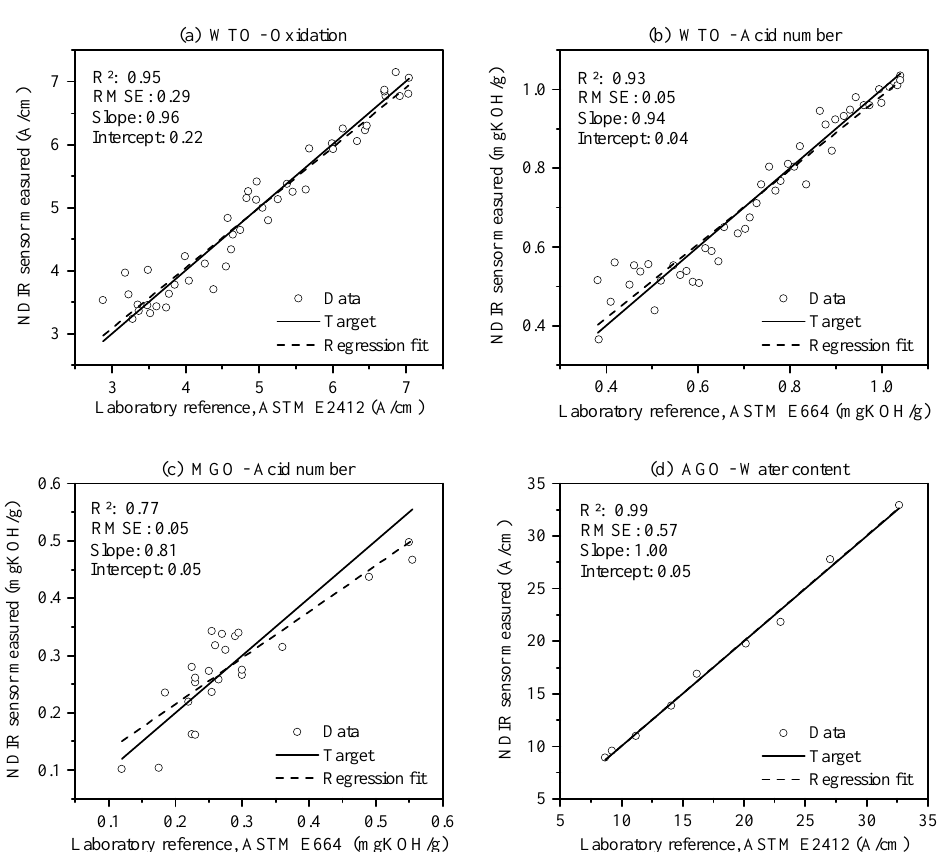
Figure 8. ( a ) Model validation for the oxidation measurement of the WTO samples; ( b ) Model validation for the AN measurement of the WTO samples; ( c ) Model validation for the AN measurement of the MGO samples; ( d ) Model validation for the water content measurement of the AGO samples. RMSE: root mean square